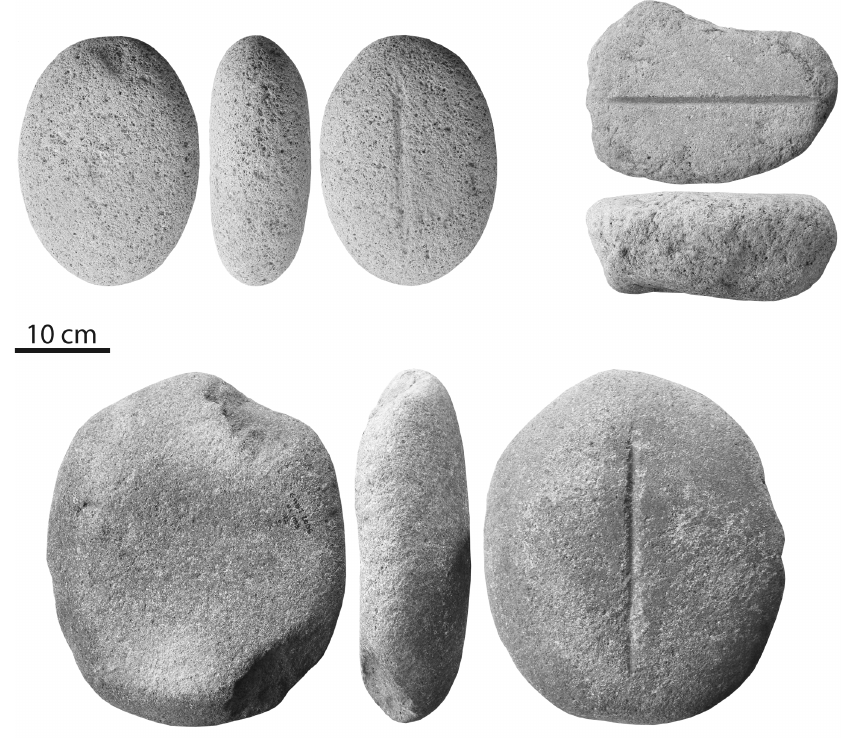
Figure 7: Grooved polishers recovered during excavations at the Gare Maritime site (modified after Fouéré,